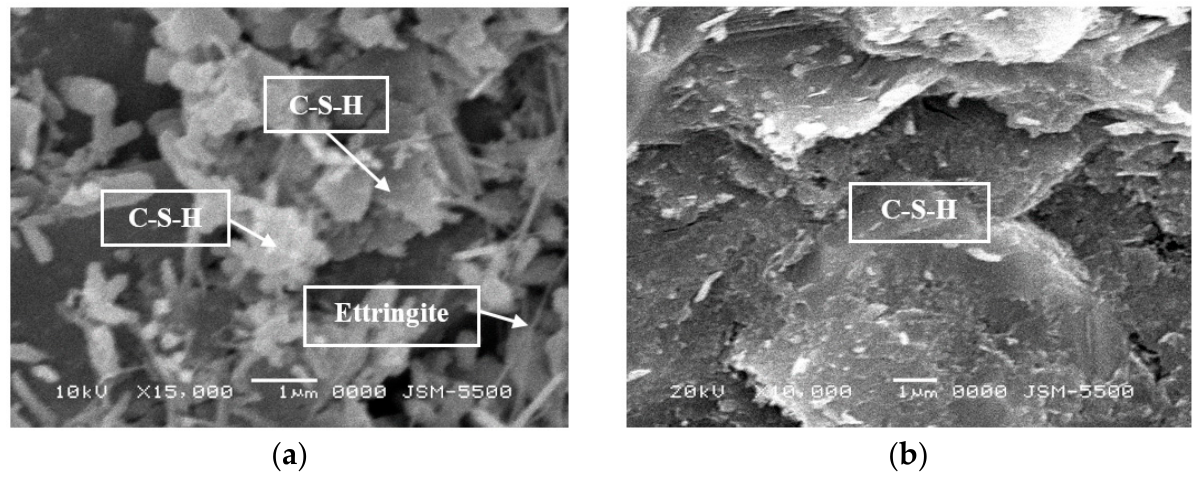
Figure 16. SEM micrograph of V3-50. ( a ) 10 kV–15 kx, ( b ) 20 kV–10 kx.